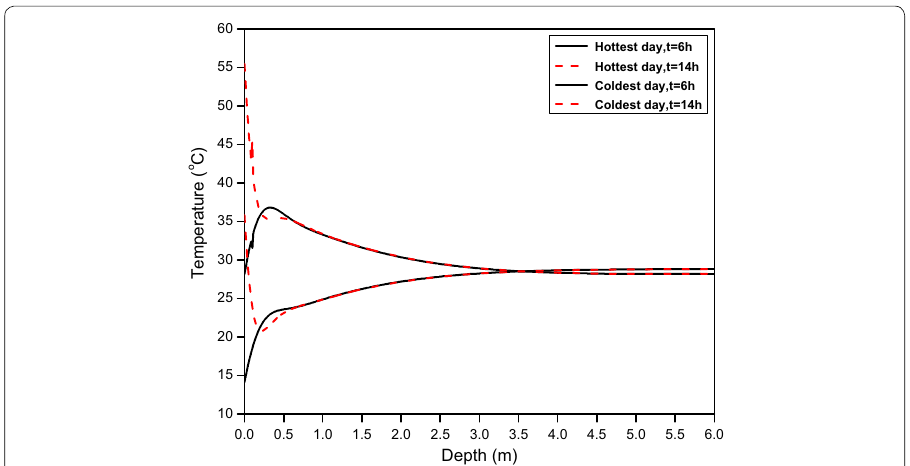
Fig. 11 Variation soil temperature with depth for the hottest and the coldest